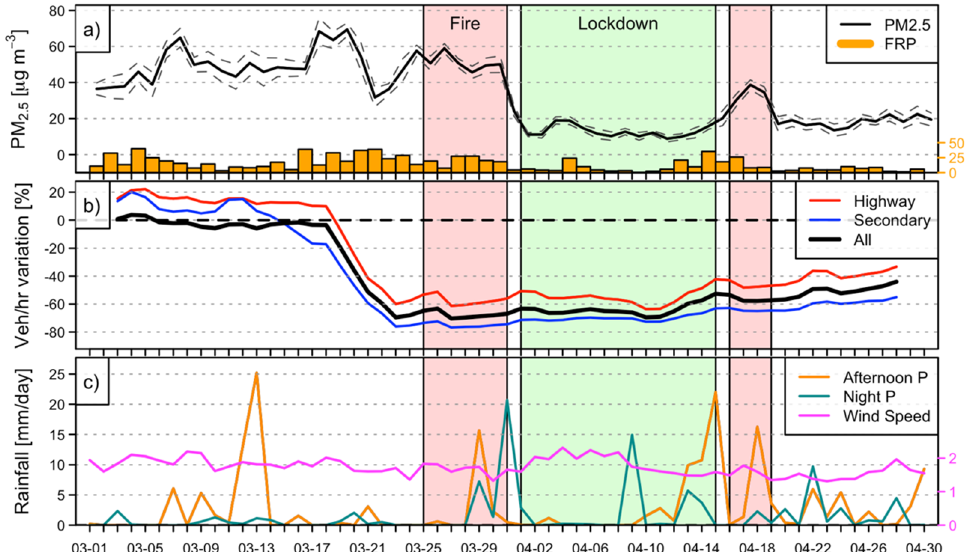
Figure 2. ( a ) AMVA mean daily PM 2.5 in black lines (24-h moving average with ± 1 standard deviations) and daily total FRP (orange bars, in GW). ( b ) Daily traffic intensity variation in 2020 relative to the 2016–2019 March–April mean for all cameras (black line) and selected cameras located in highways (red line) and secondary roads (blue line). ( c ) Mean daily wind speed (magenta) and accumulated rainfall during the afternoon (orange) and night (green). The Lockdown (Fire) period is highlighted in green (red).